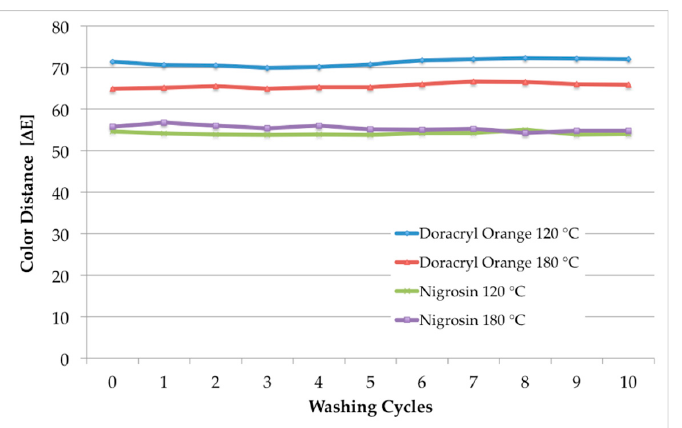
Figure 12. Color distances of amorphous m-aramid fabrics dyed in EMIM-EtSO 4 with Doracryl Orange and Nigrosin at 120 °C and 180 °C, respectively, after 1, 5 and 10 washing cycles.